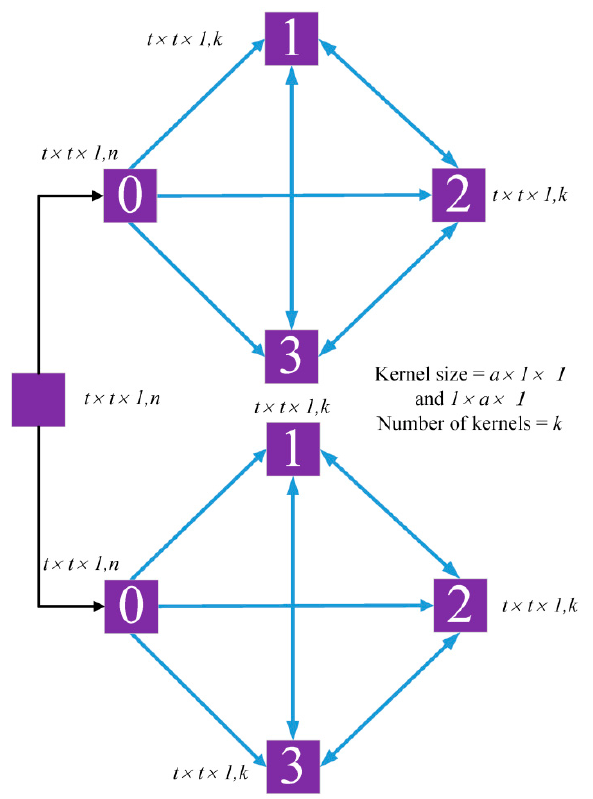
Figure 4. A representation of the alternately updated spatial block with two different convolutional kernels and three convolutional layers for each convolutional kernel.